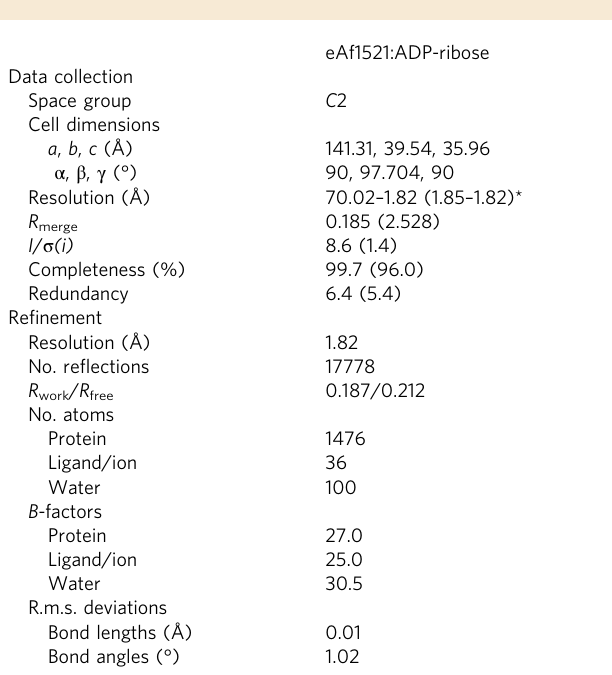
Table 2 Data collection and re fi nement